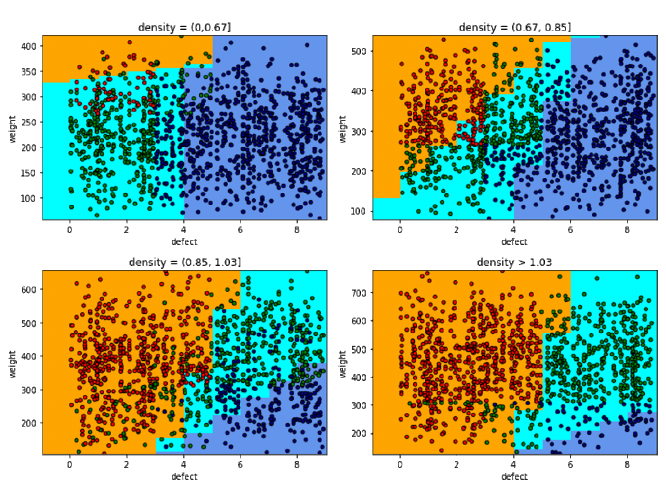
Figure 20. Classification of LDA model.